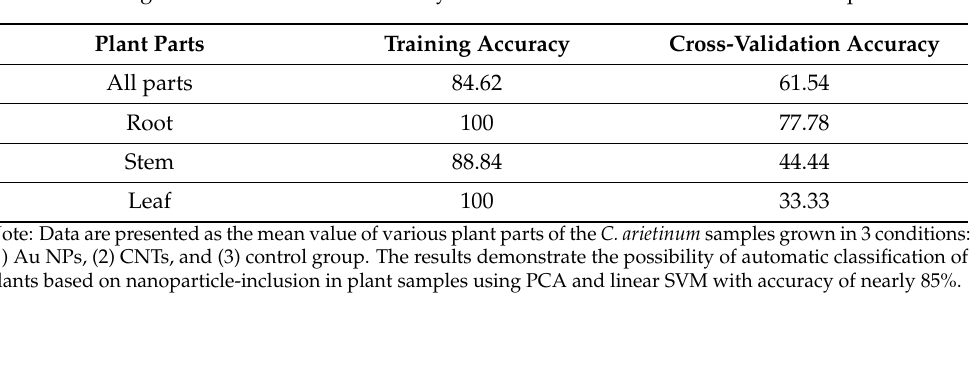
Table 3. Training and cross-validation accuracy of the SVM classification for ATR-FTIR spectral